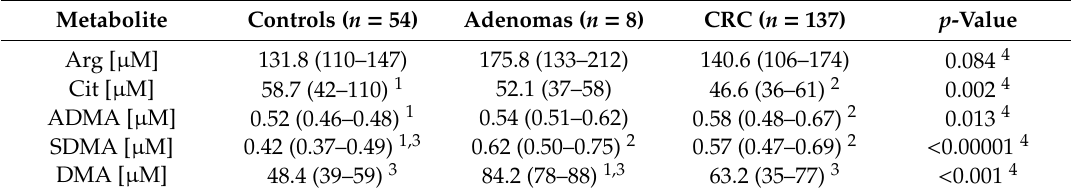
Table 3. Systemic concentrations of L-arginine / NO pathway metabolites in CRC.